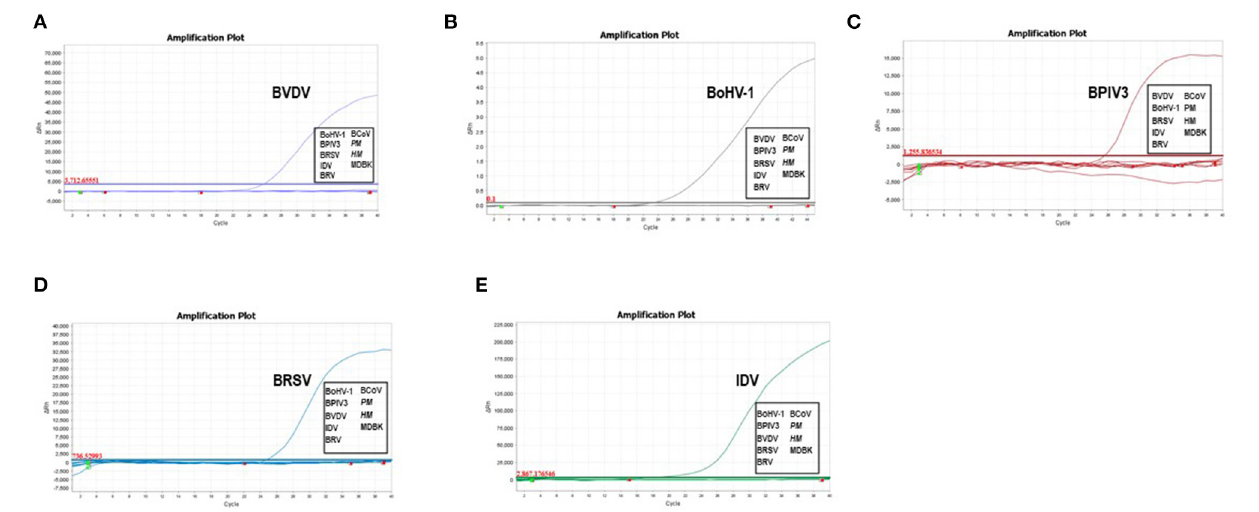
FIGURE 1 | Analytical specificity of the primer/probe sets used in the one-step real-time RT-PCR assay: Amplification curves represent samples positive for BVDV, BoHV-1, BPIV3, BRSV and IDV detected by the real-time qRT-PCR assay. Negative samples include BCoV, BRV, Pasteurella multocida and Mannheimia haemolytica . Equal amount of isolated viral/bacterial genome were mixed for the assay. The non-detected samples were highlighted in the box.